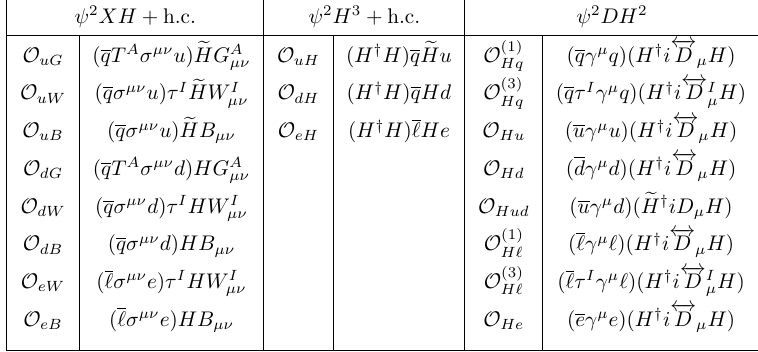
Table 8 . SMEFT two-fermion operators.